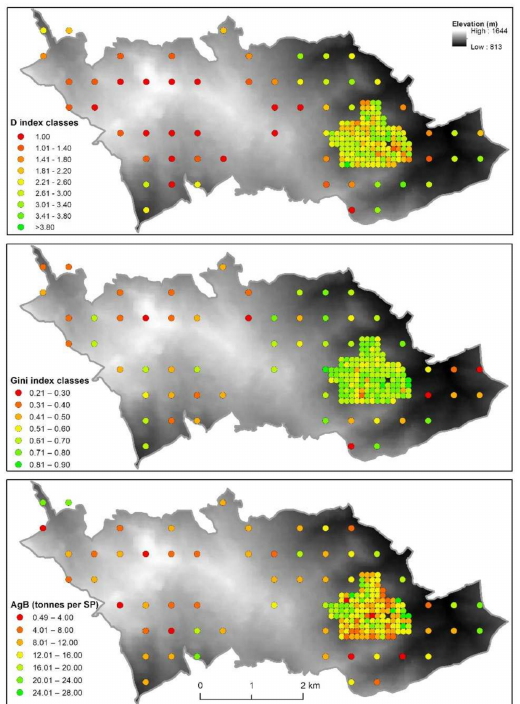
Figure 7. Spatial variation in: tree species diversity; tree size heterogeneity and aboveground biomass of living trees within Sl ă tioara-Rar ă u